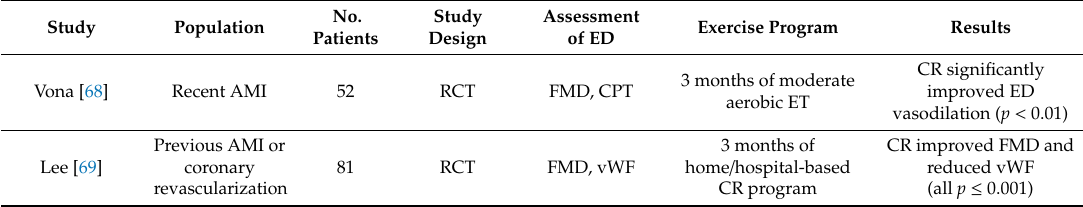
Table 1. Summary of the main studies that assessed the e ff ects of cardiac rehabilitation (CR) on endothelial